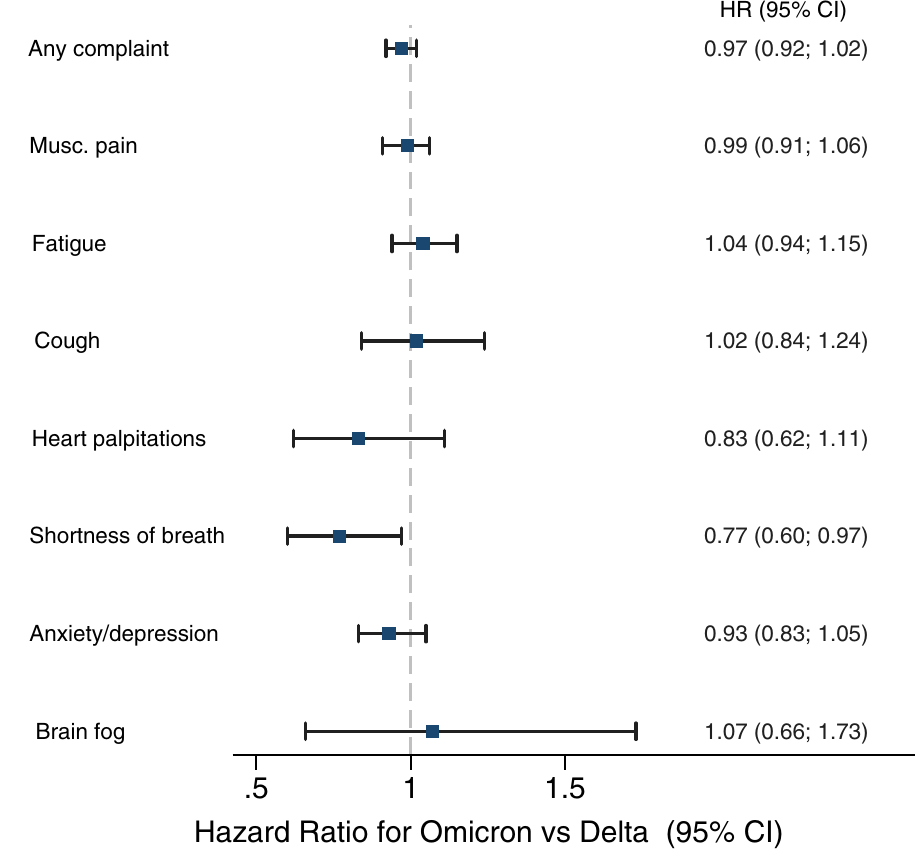
Fig.2|Risksofcomplaintsfrom14toupto126daysafterSARS-CoV-2infection with the Omicron variant ( n =13,365), adjusted for age, sex, education, comorbidities, test and care activity and vaccination. Reference category: per- sons with SARS-CoV-2 Delta (dashed vertical line) ( n =23,767). Data are presented